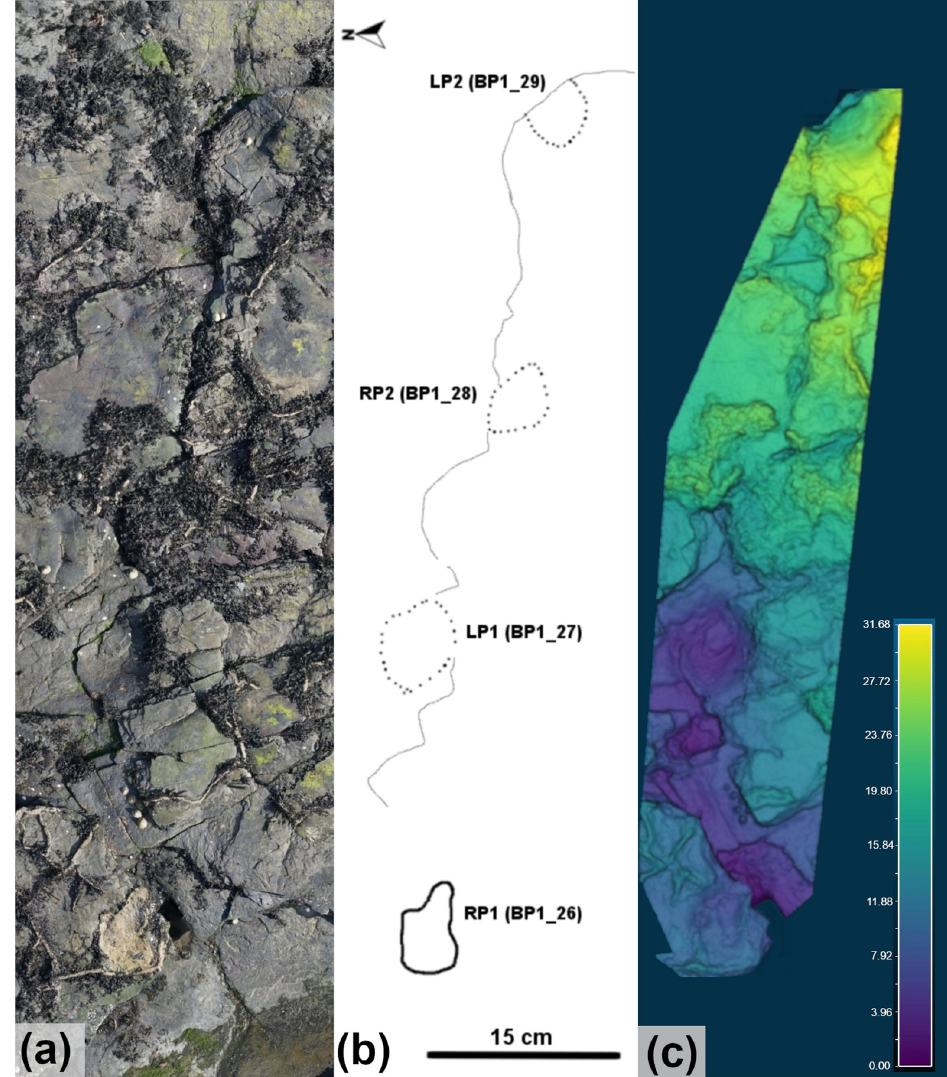
Fig 14. Overview of BP1_Twy_03. BP1_Twy_03 is shown as an (a) orthophoto, (b) a line drawing, and (c) a false color depth map. The trackway spans the whole southern portion of the main track-bearing platform with BP1_29 being present solely as a broken heel mark on the platform edge. The color scale of (c) is in units of